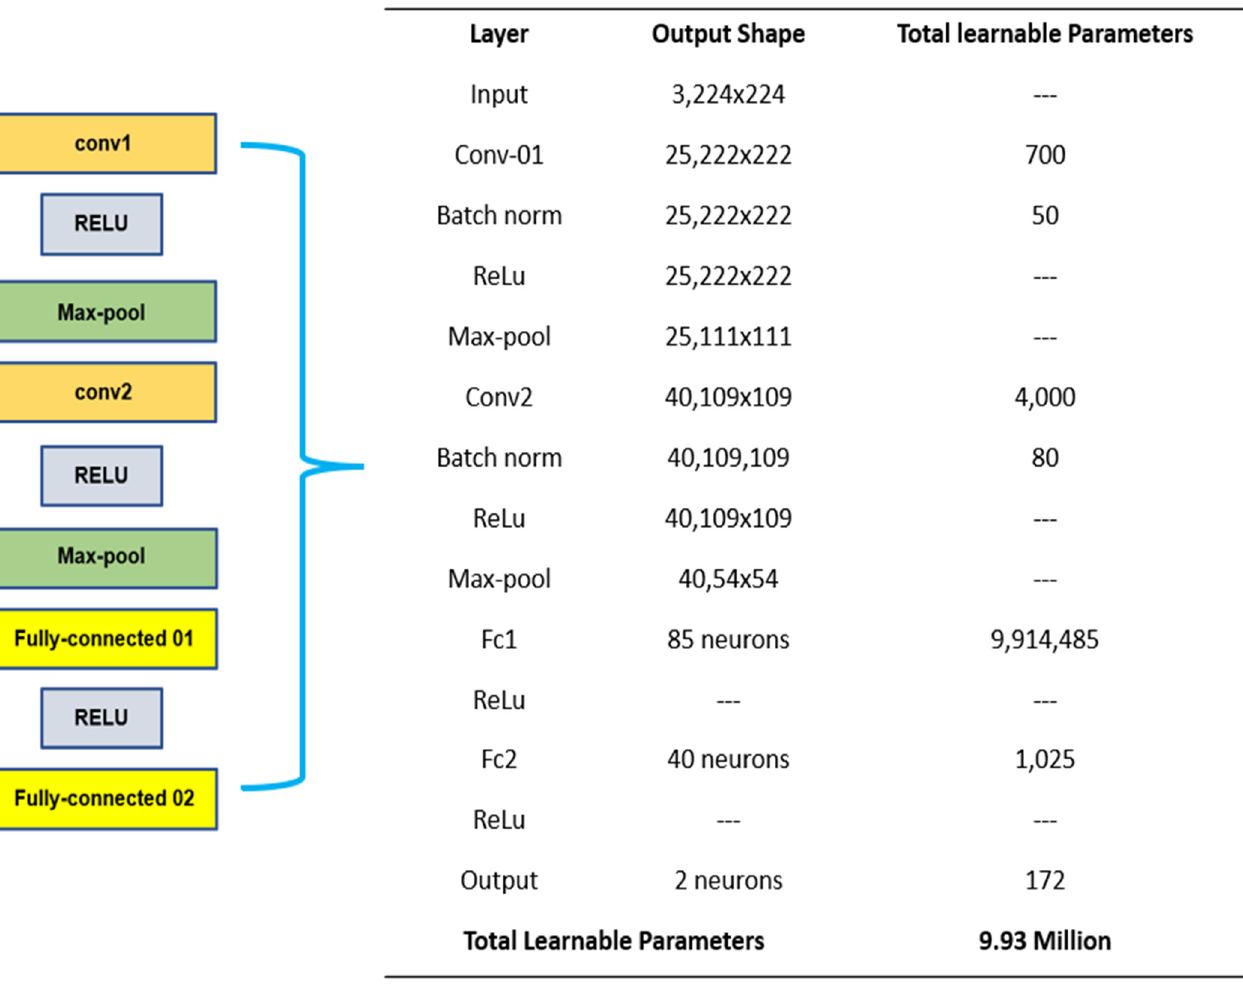
Figure 11. Proposed CNN Internal Block Diagram.